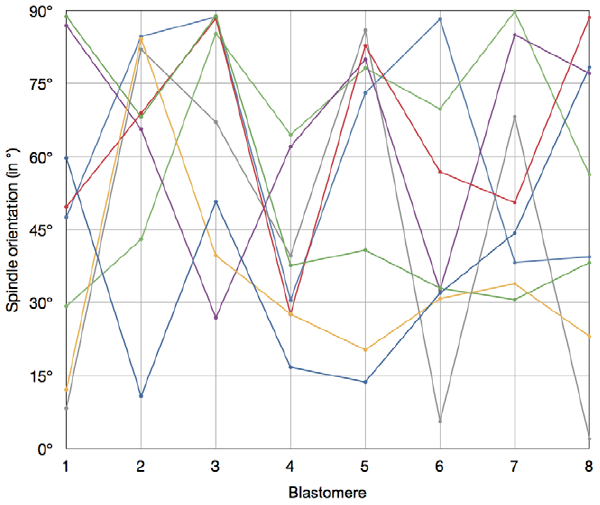
Figure 4. Orientation of the eight mitotic spindles in 8-cell stage mouse embryos. Each colour corresponds to a given embryo. Spindle orientation (in degrees; Y axis) was measured for each blastomere (X axis). Blastomeres were ranked according to the timing of mitosis. No define pattern could be observed.